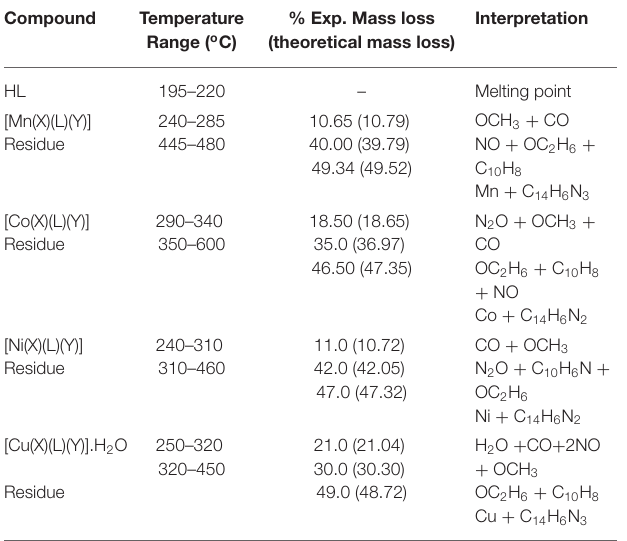
TABLE 1 | Thermal data presentation of HL and its complexes.